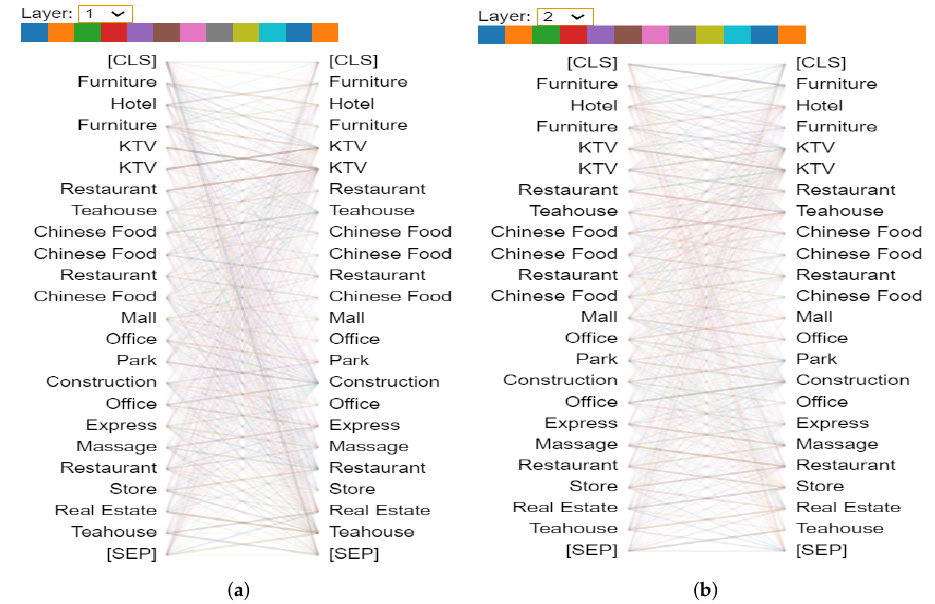
Figure 16. Attention Layer 1 and Layer 2 in GeoBERT-CenterDistance. Pairs of cross lines between adjacent tokens can be clearly observed, and the conclusion is similar to the shortest Path. Moreover, most of these signs occur at shallow attention layers, basically from Layer 0 to Layer 2. Thus, we believe that in the shallow attention layers, GeoBERT learns the position information among POIs: